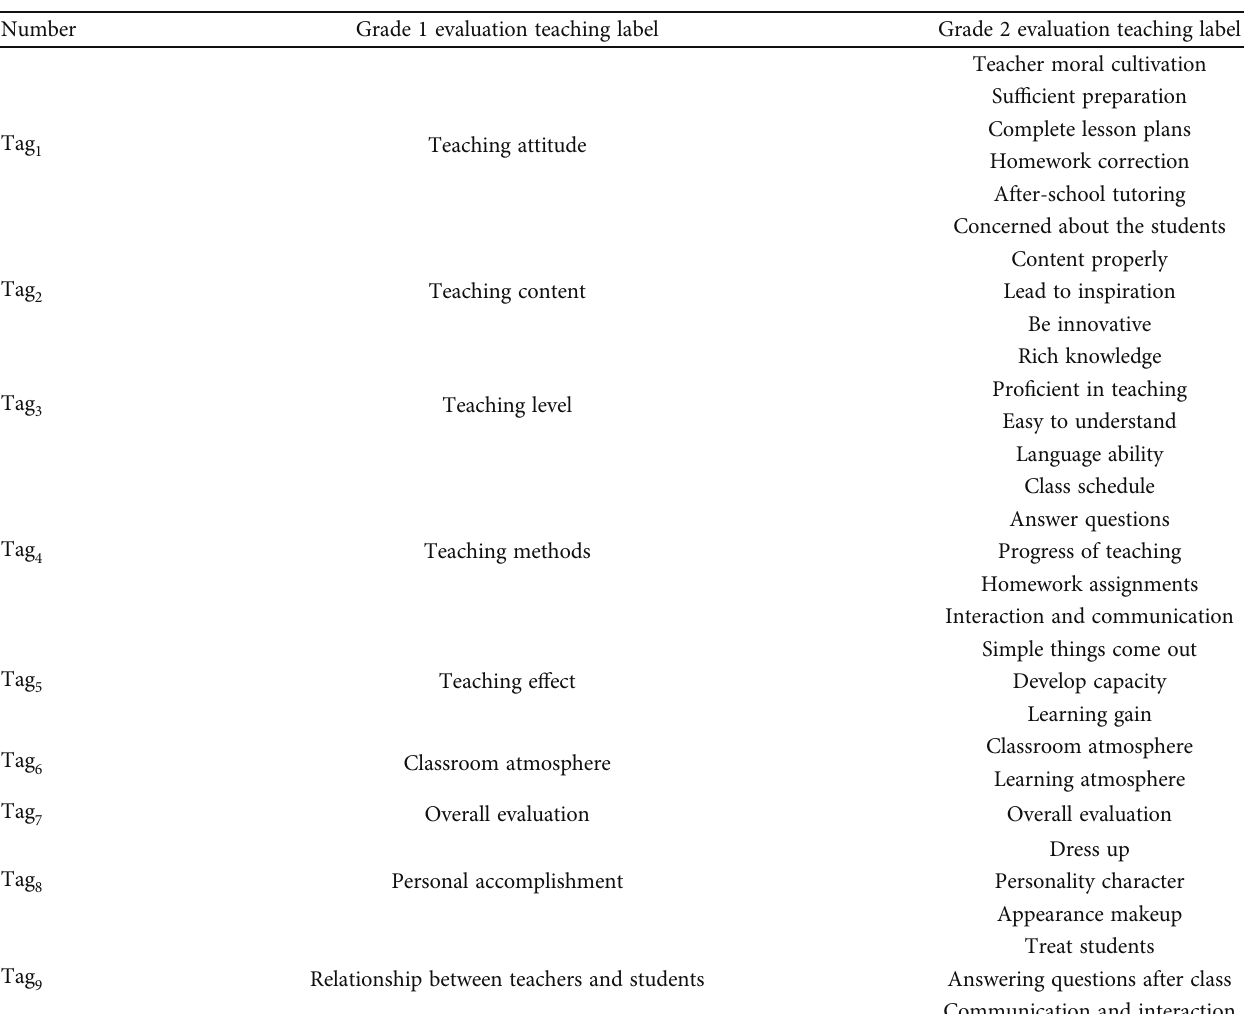
Table 5: Teaching evaluation label system from the perspective of